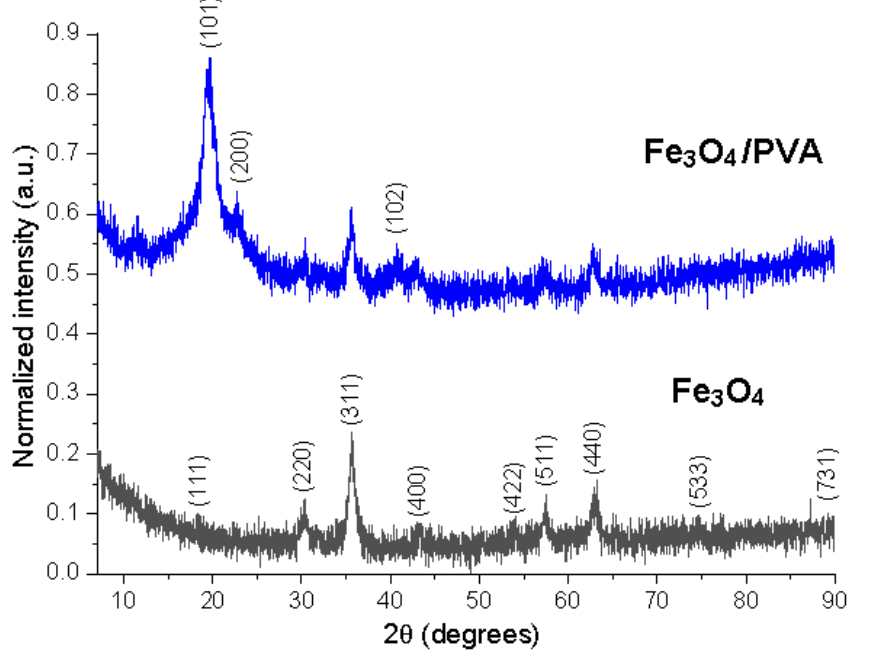
Figure 4. X-ray diffractograms of the Fe 3 O 4 and Fe 3 O 4 /PVA—normalized intensities. The surface morphology of the prepared magnetite (Fe 3 O 4 ) and modified magnetite (Fe 3 O 4 /PVA) was examined using SEM analysis (magnification 200,000 × ), which is shown in Figure 5.